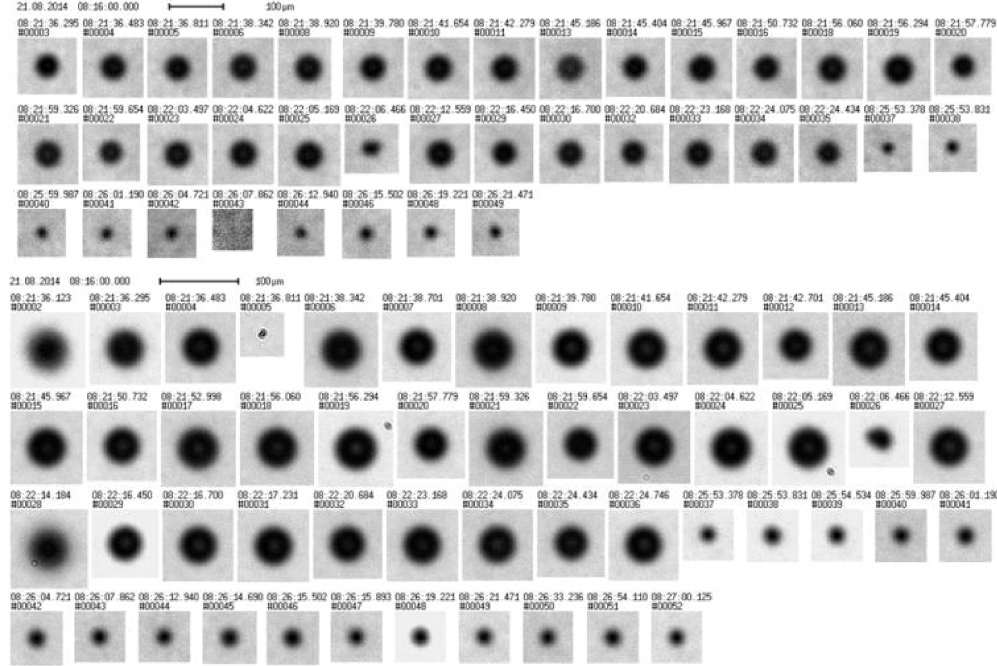
Figure 10. A series of processed images captured by the CTA 1 (4-fold magnification, upper panel) and CTA 2 (6-fold magnification, lower panel) for 50 and 20µm glass bead standards. Note: less than about 1 % of all images are empty which sometimes is not recognized by the analysis algorithm (image number 43 in the upper panel). These empty images are especially accepted when dirt particles are present on the telescope optics like in the case of image number 5 in the lower panel. Table 4. Statistical results of the image analysis of glass bead standard measurements. SD denotes standard deviation.